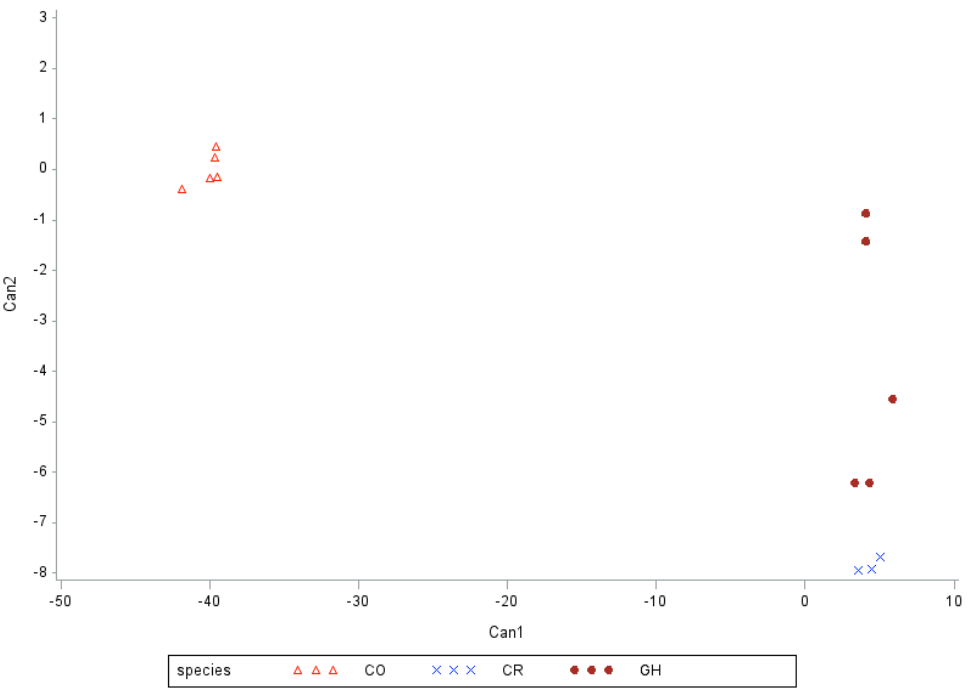
Figure 5. Scatter plot of first two factors from discriminant function analysis for Diodontidae from southeastern India.